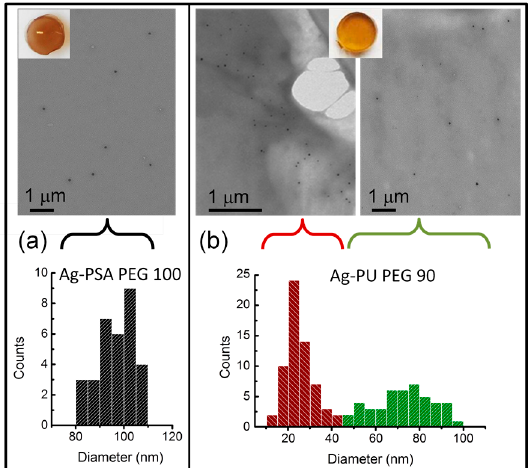
Figure 3. Representative bright field S-TEM images (upper) and respective five-bin histograms showing the size-distribution of AgNPs (below) prepared in Ag–PSA PEG 100 ( a ) and Ag–PU PEG 90 ( b ) hydrogel nanocomposites. Insets reproduce the light photograph of each Ag-hydrogel nanocomposite. Polyurethane-based nanocomposites show two different NP size-populations (25 ± 8 nm and 73 ± 13 nm right representations).